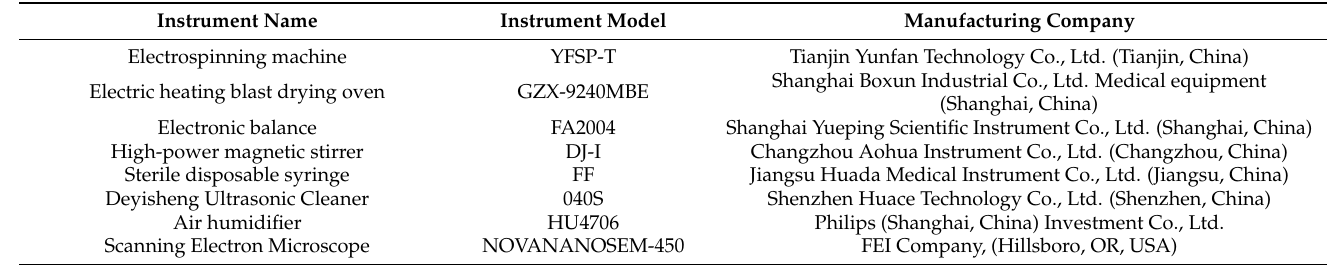
Table 1. Experimental instruments and equipment.